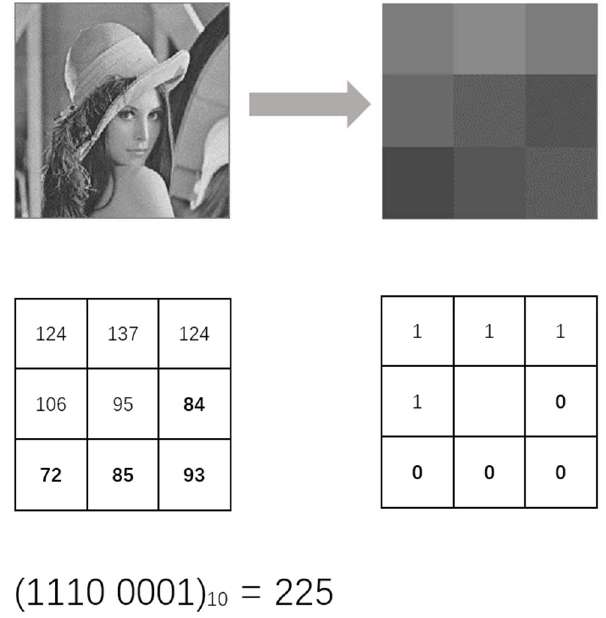
Figure 3. Local binary patterns (LBP) operator.